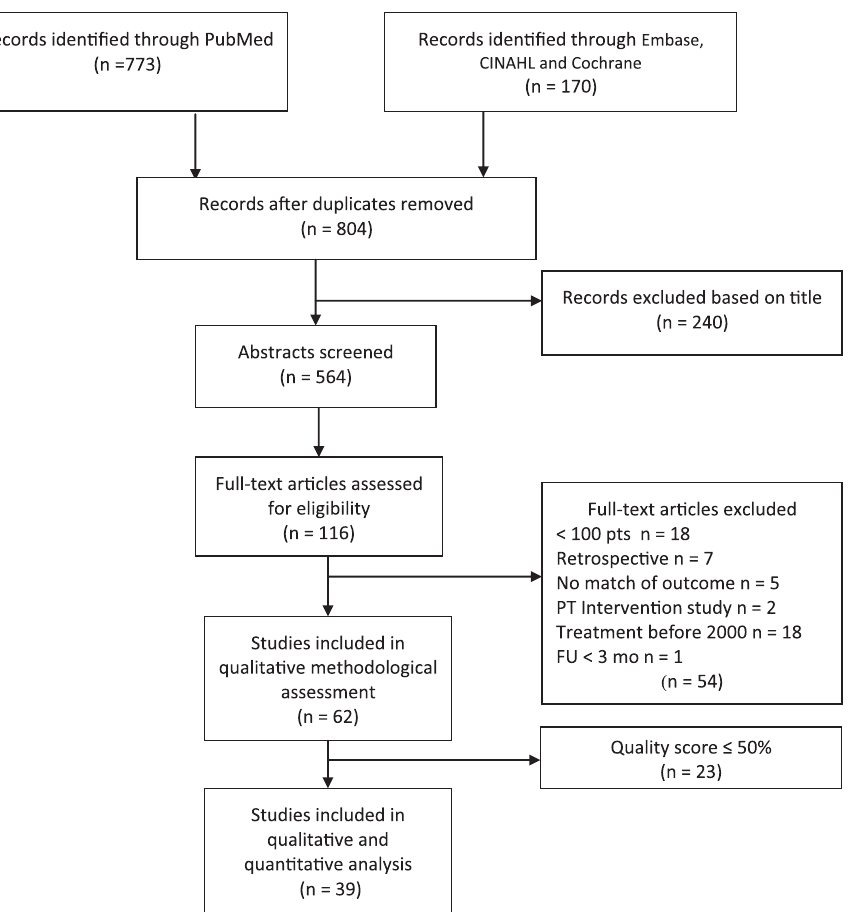
Figure 1. Flow diagram literature search adverse effects of breast cancer treatment.